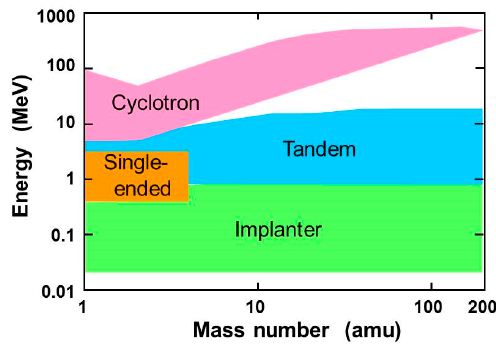
Figure 3. Range of ion species and beam energies covered by the four accelerators.